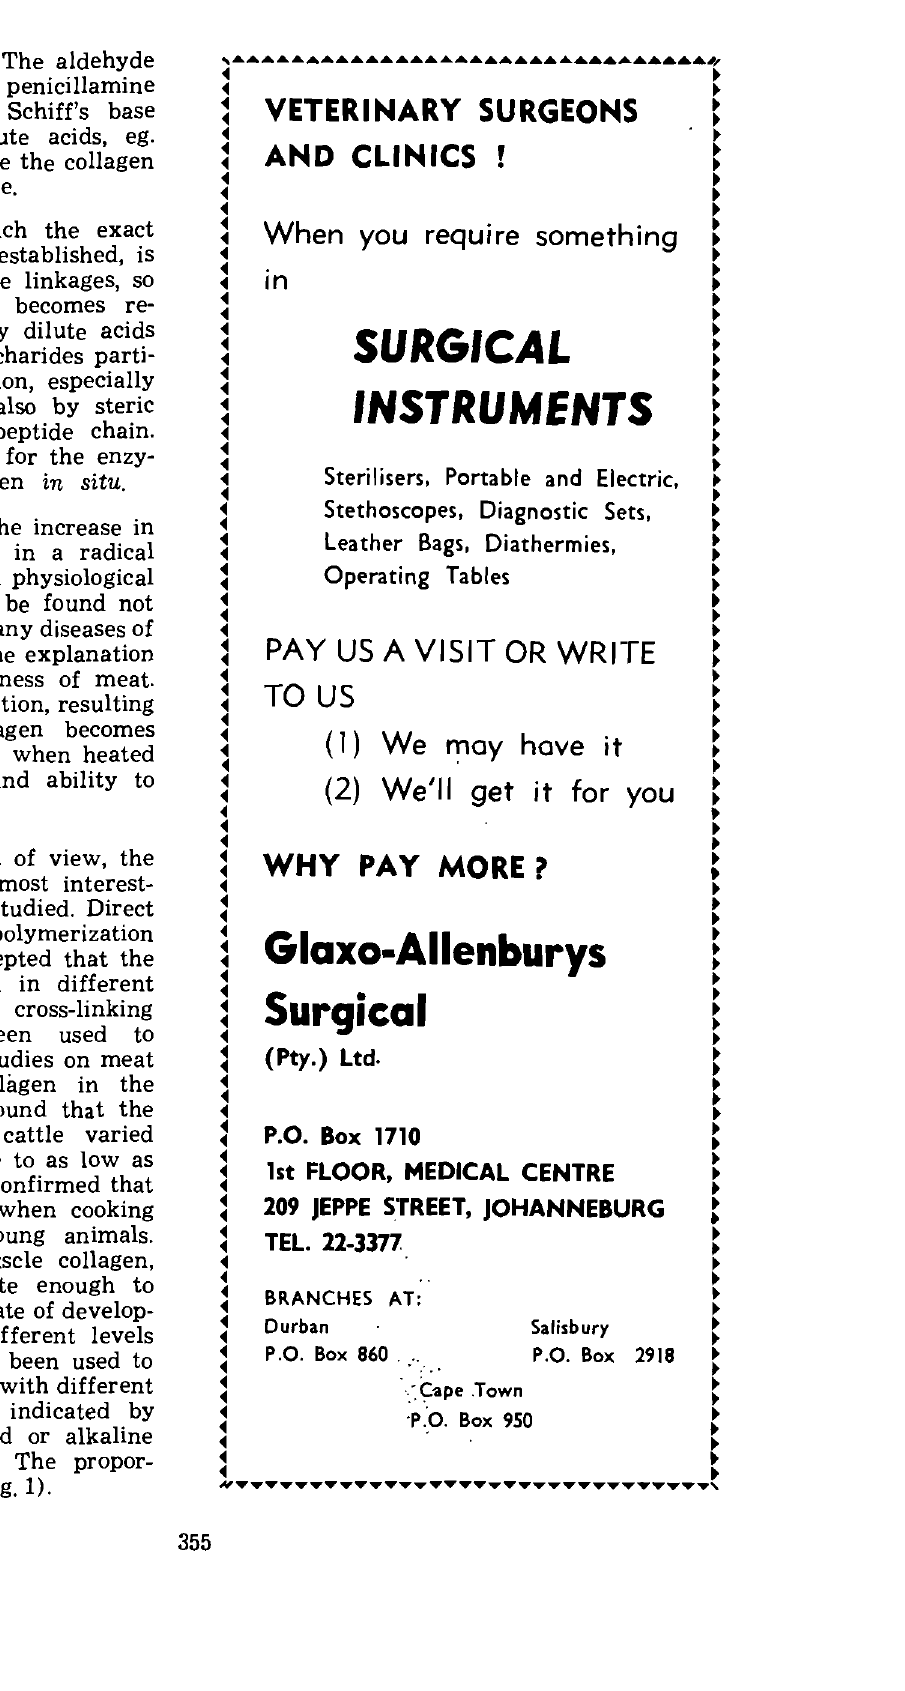
Stethoscopes, Diagnostic